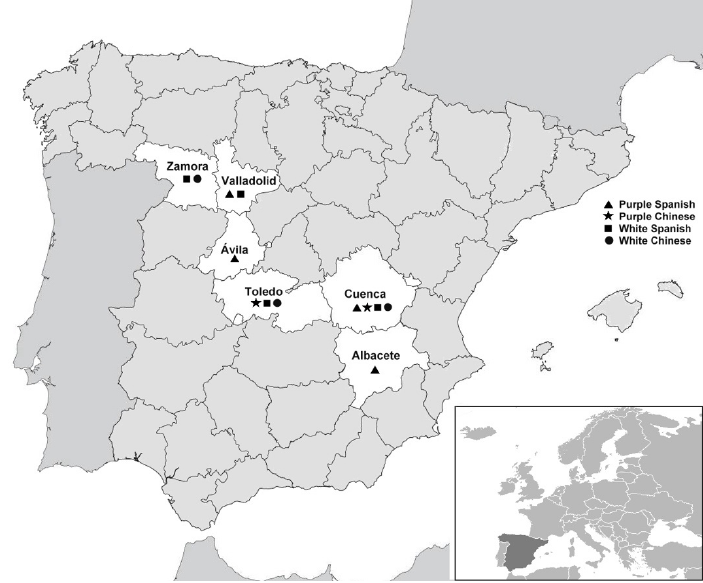
Figure 1. Map of Spain indicating the six provinces surveyed in this study (white area). The different symbols indicate the type of garlic analyzed in each province.